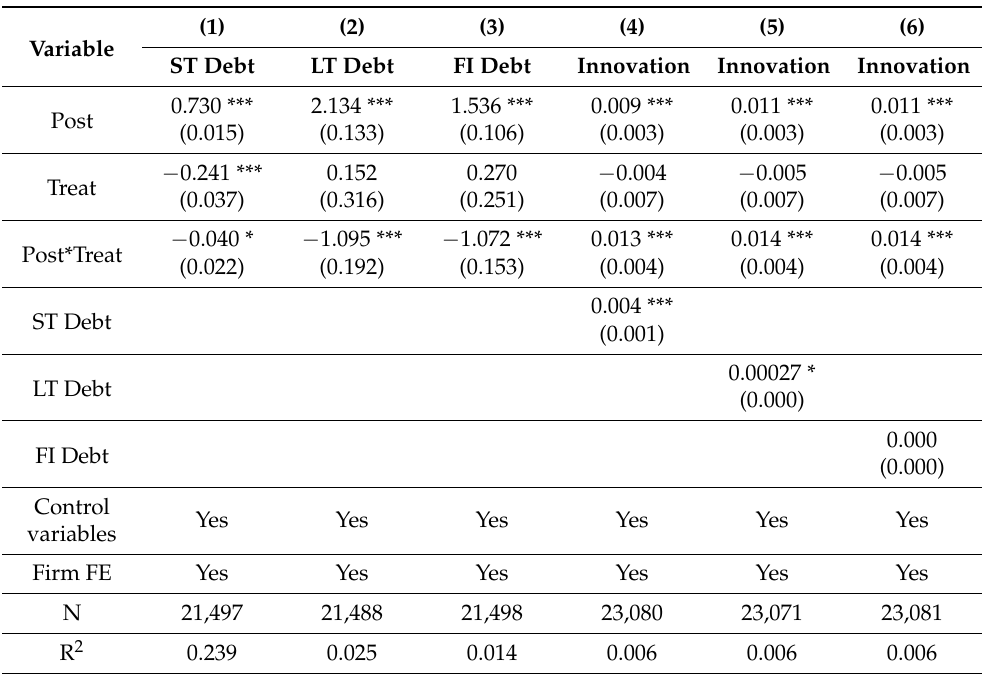
Table 6. An empirical test of green credit guidelines, financing level, and green technology